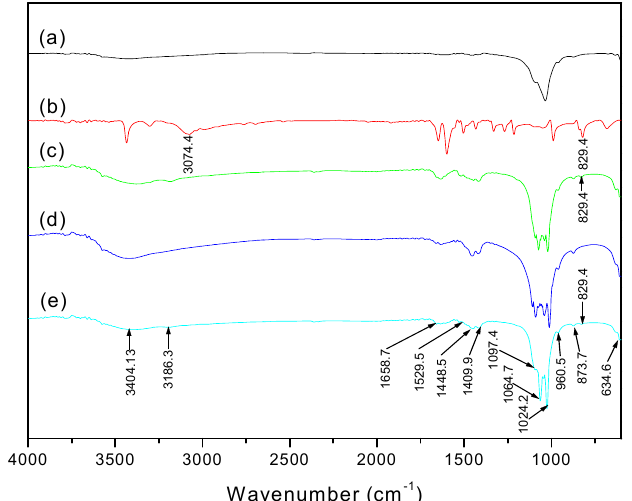
Figure 3. FTIR spectra of ( a ) HAP, ( b ) 4AP, ( c ) HAP_4AP_25, ( d ) Si–HAP, and ( e ) Si–HAP_4AP_25 samples.